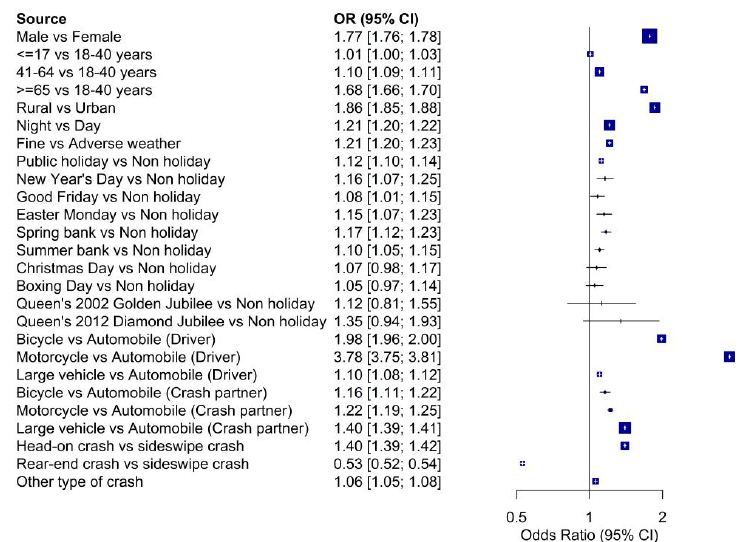
Figure A3. Forest plot of odds ratio from simple logistic regression analysis for each independent variables using the UK STATS19 data [24].